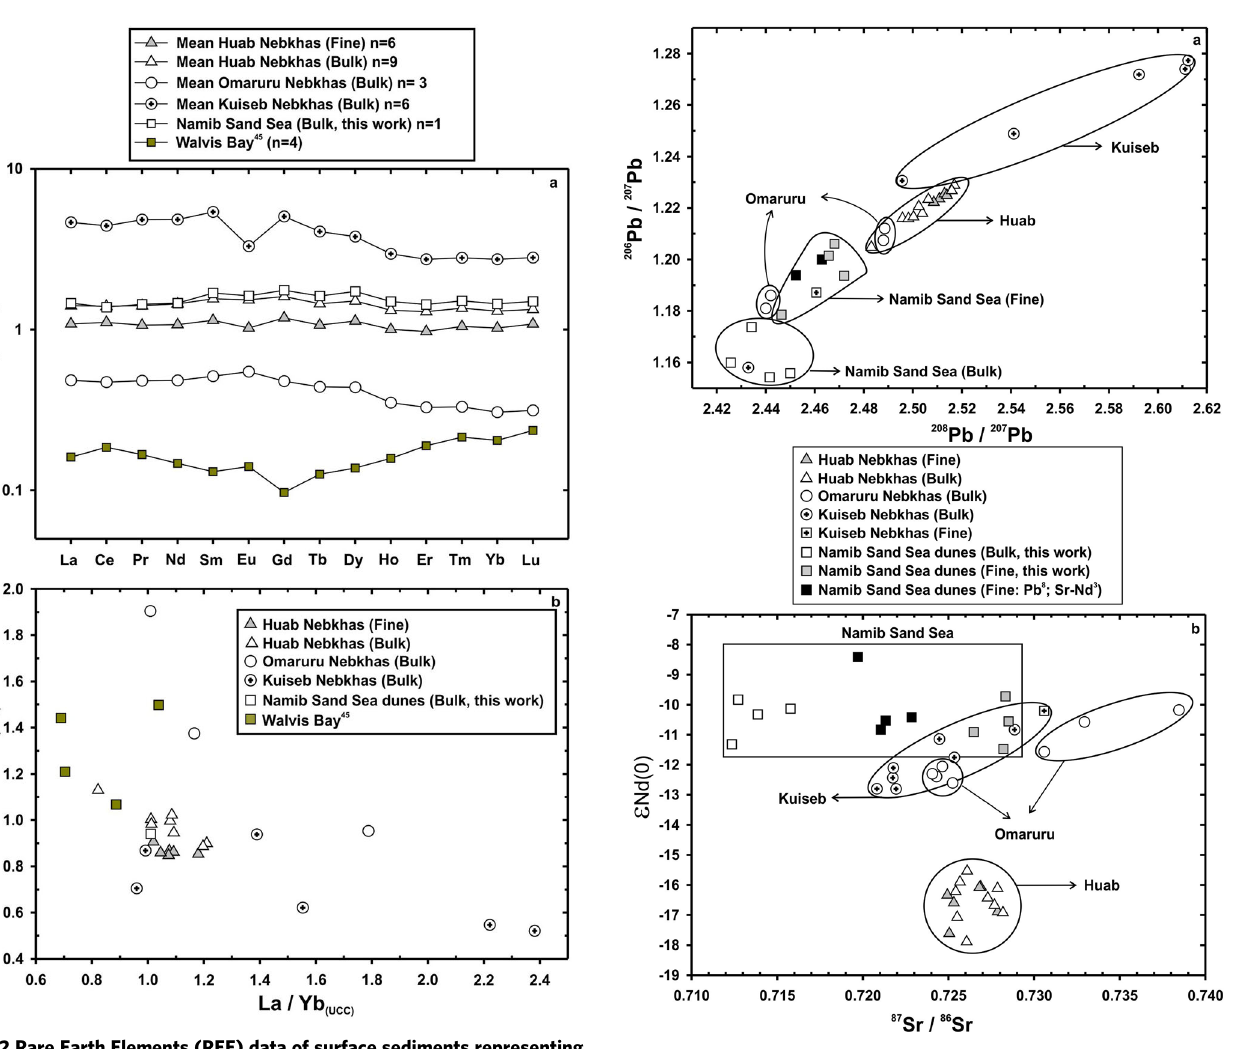
Fig. 3 Sr-Nd-Pb isotopic compositions of Southern Africa sediments. a 208 Pb/ 207 Pb vs. 206 Pb/ 207 Pb. b 87 Sr/ 86 Sr vs. ε Nd(0). Grain size effects on Sr-Nd-Pb isotopic compositions for the Huab and Namib Sand Sea are also shown and indicated by symbols in gray ( fi ne) and open symbol